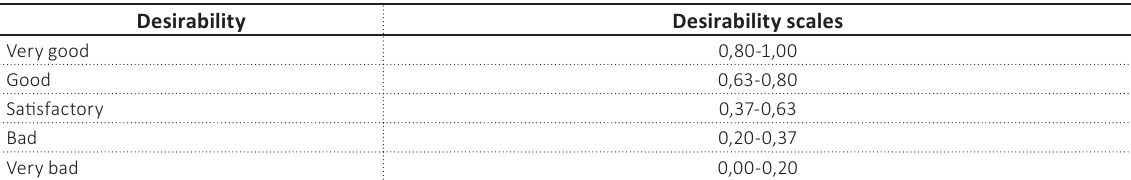
Table 5. The value of Harrington desirability